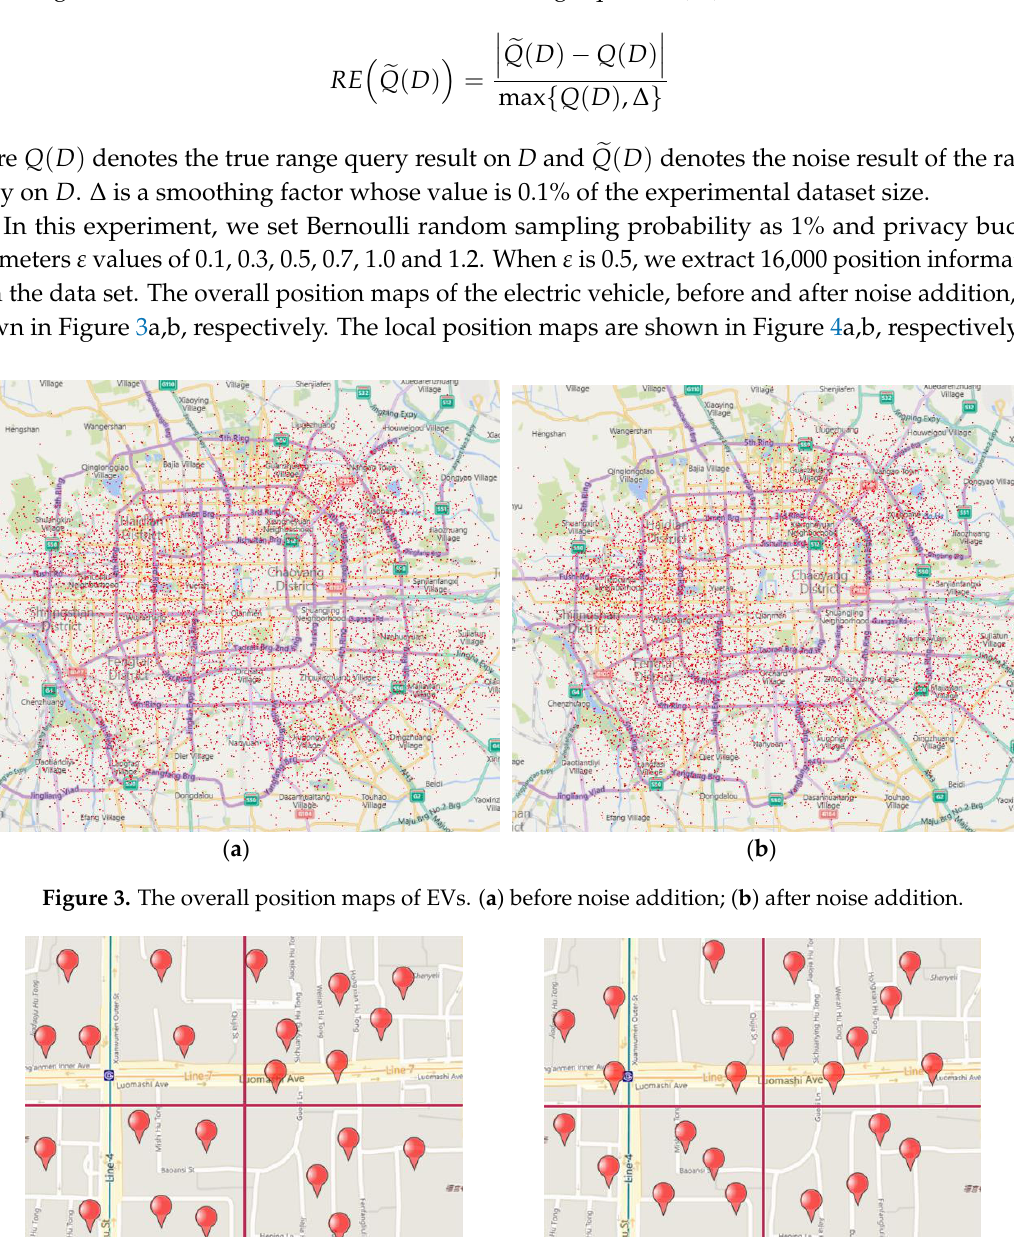
Figure 5. Query range Q = 1%. 0.1